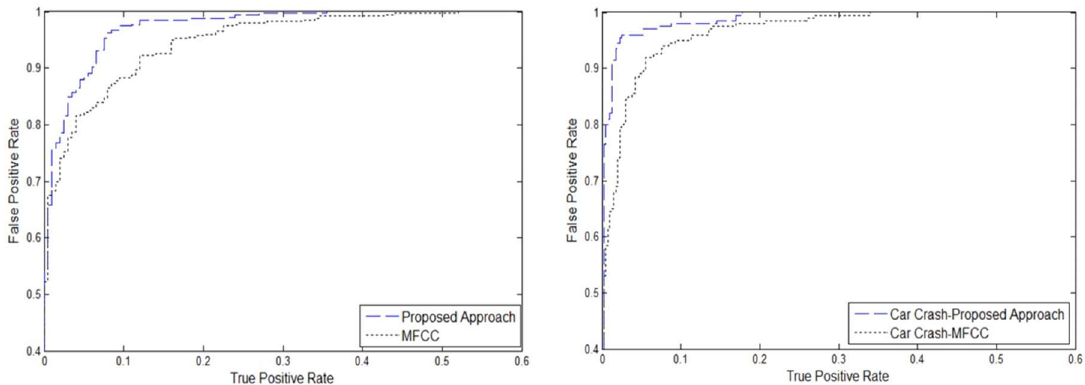
Figure 6. Receiver operating characteristic (ROC) curves of the proposed system configured with Mel-frequency cepstral coefficient (MFCC) features.